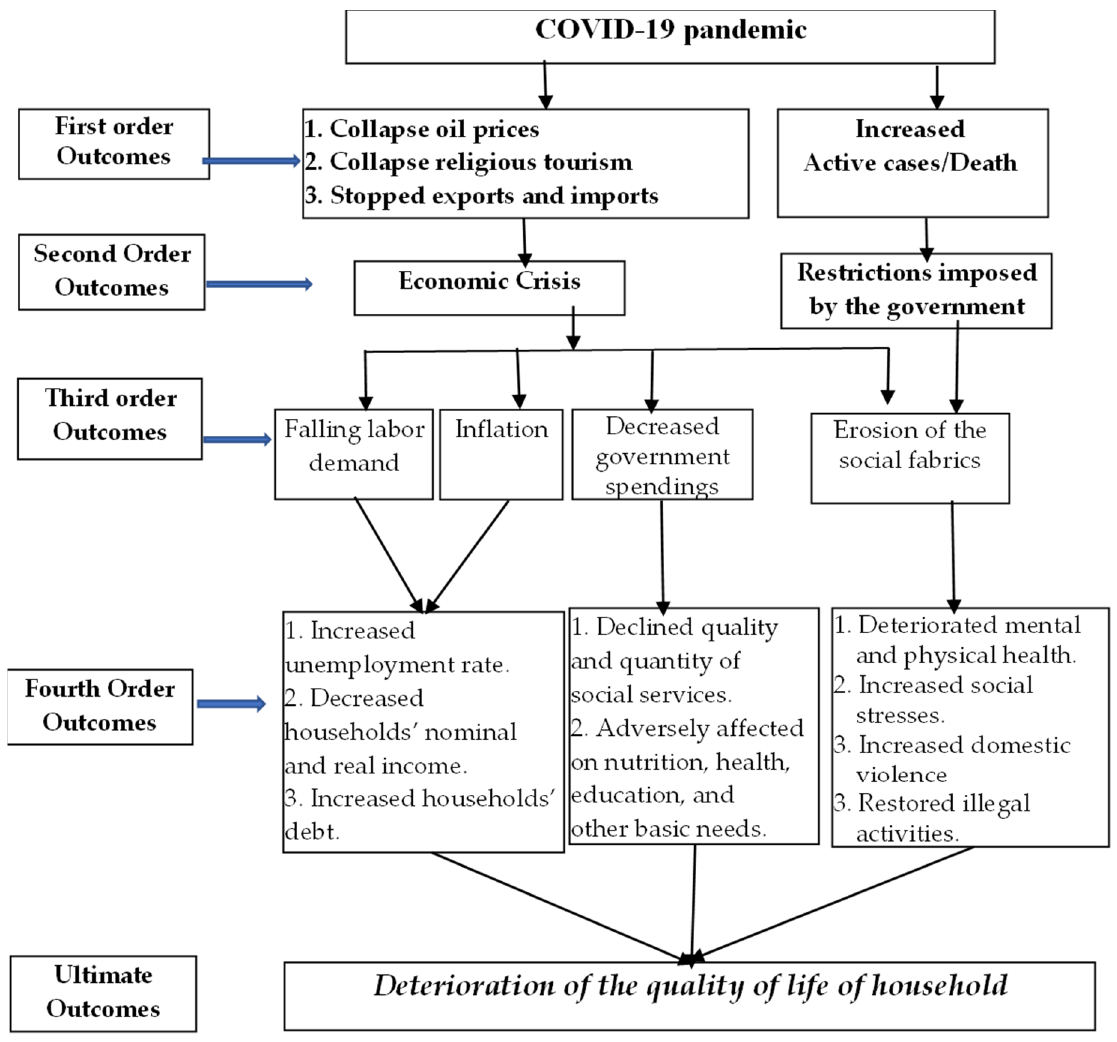
Figure 1. Transmission of the impact on QoL by COVID-19 at the micro-economic/household